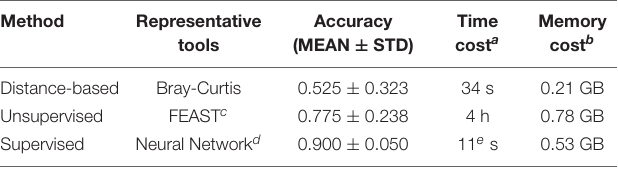
TABLE 3 | The comparisons of current methods for microbiome sample searches’ accuracy and